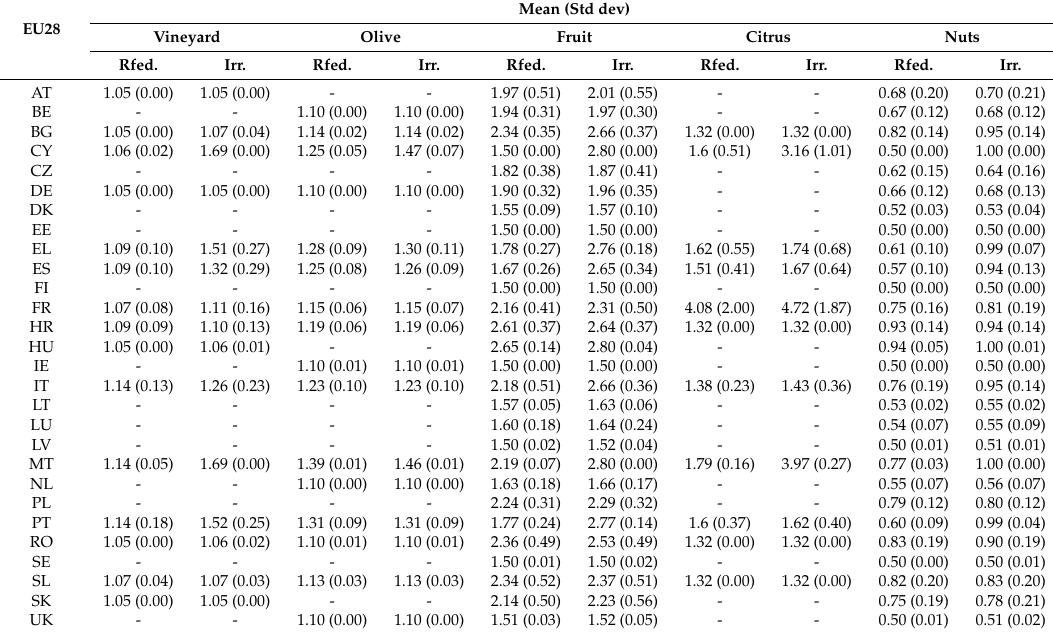
Table 5. Summary of RSR results (t · ha − 1 d.m.) by crop group by country in EU28. Mean (Std dev) EU28 Vineyard Olive Fruit Citrus Nuts Rfed. Irr. Rfed. Irr. Rfed. Irr. Rfed. Irr. Rfed. Irr. AT